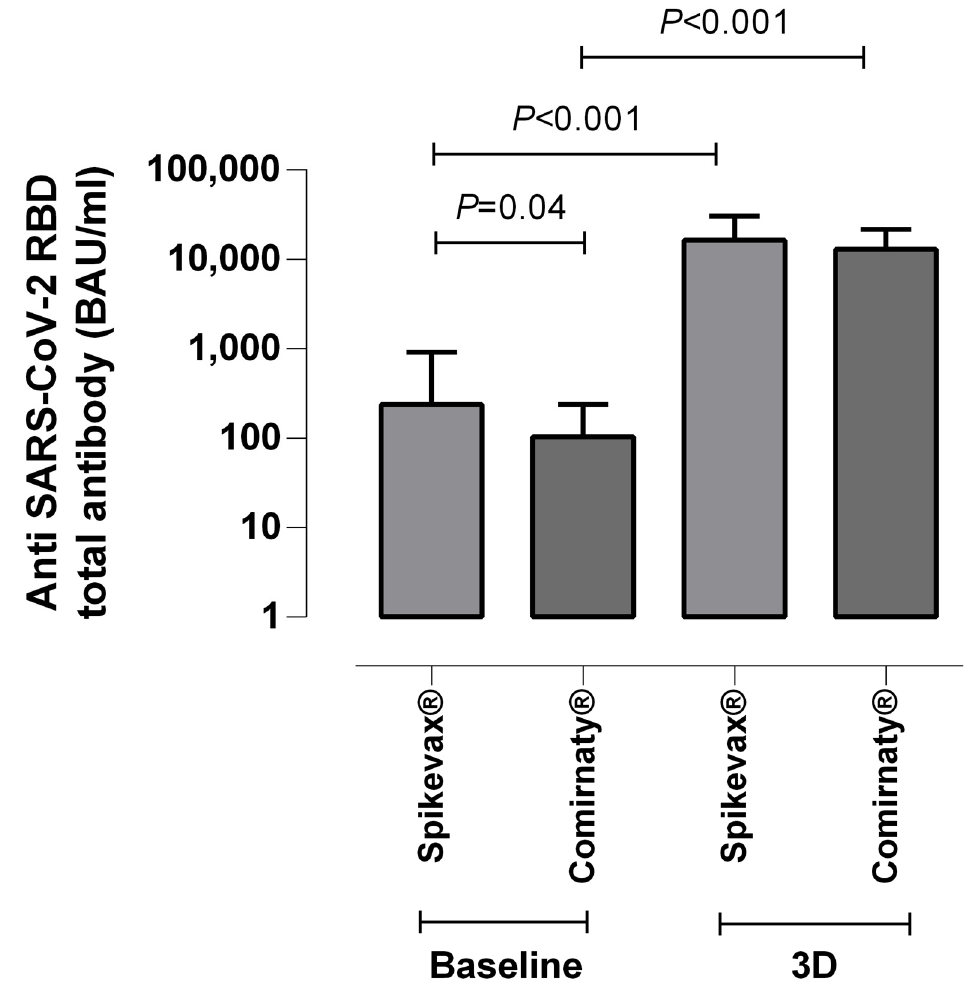
Figure 2. Dot-plot with median and interquartile range depicting receptor binding domain (RBD)- reactive total antibodies (in BAU/mL) measured at baseline and after receipt of a homologous mRNA COVID-19 third dose in hemodialysis patients vaccinated with either Spikevax ® or Comirnaty ® COVID-19 vaccine; p -values for comparisons across groups are shown.